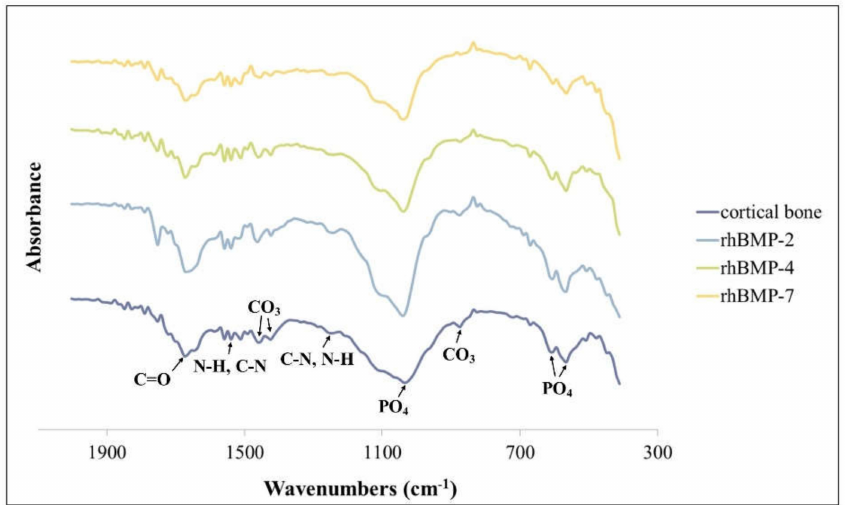
Figure 4. FT-IR spectra of rhBMP-2, rhBMP-4, and rhBMP-7 samples two weeks after cultivation and rat calvarial cortical bone.